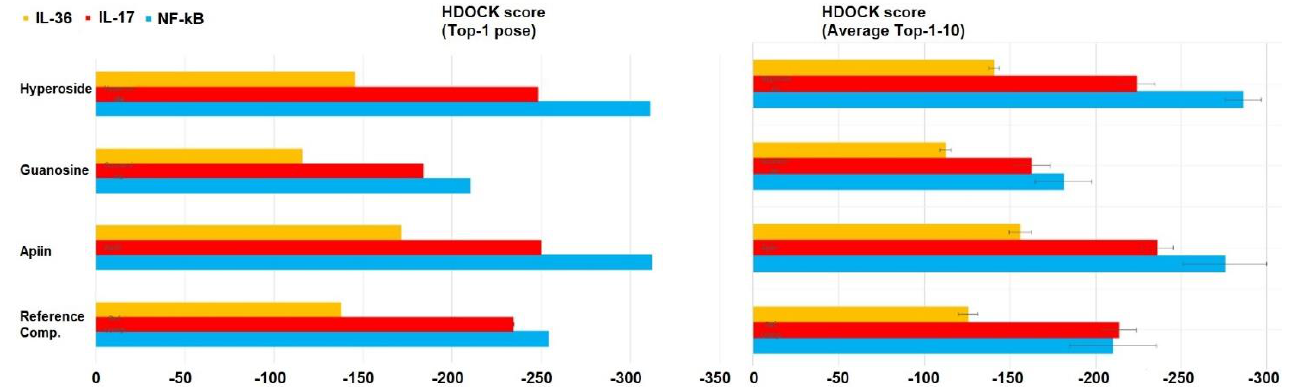
Figure 2. HDOCK scoring of complexes of the three protein targets (NF-kB, IL-17 and IL-36) involved in psoriasis investigated in our study with the plant metabolites hyperoside, guanosine, apiin and their respective reference inhibitors. Note how the scores for the top-ranked (Top-1) poses are presented in the left side of the figure, while the means (considering the values for poses Top1–10) with the respective Standard Deviations are shown on the right.